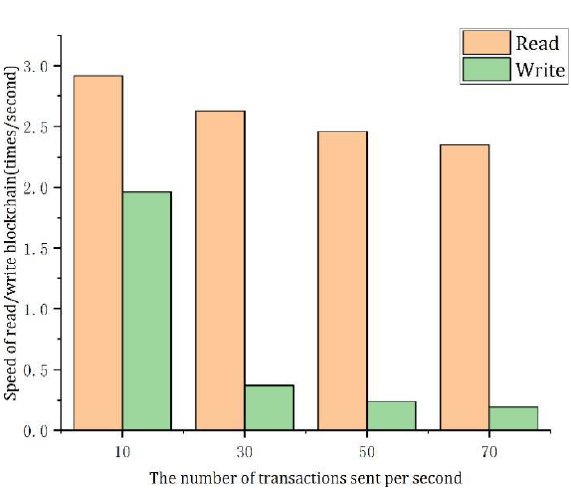
Figure 8. Read/write blockchain speed for 10 peer nodes.